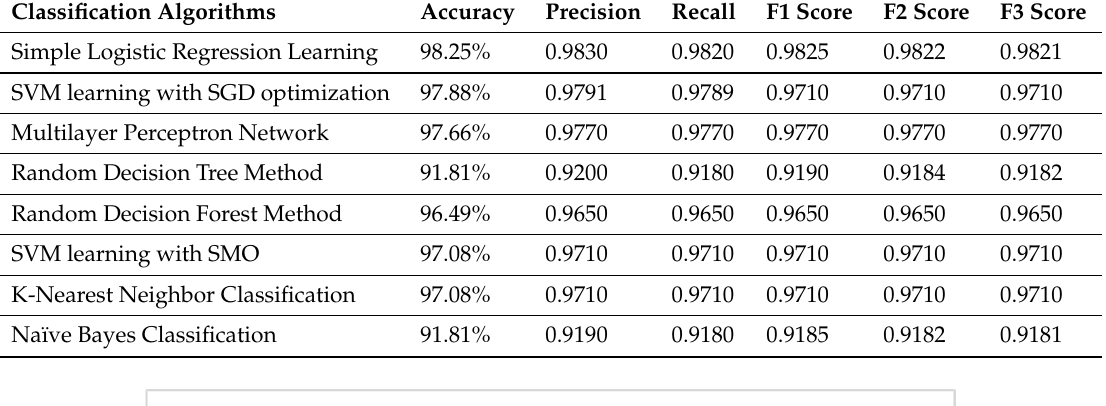
Table 2. Performance of the machine learning algorithms on WBCD.